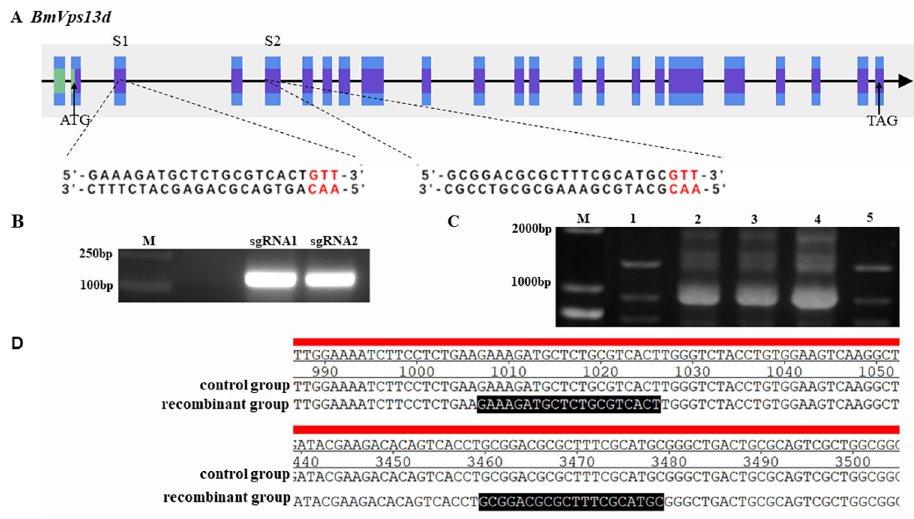
Fig 5. Cas9/sgRNA mediated gene editing of BmVps13d . (A) Schematic diagram of the sgRNA-target sites in BmVps13d . The purple boxes represent exons, and the black lines represent the gene locus. S1 and S2 are sgRNA sites shared in exon 2 and exon 4, respectively. The sgRNA target sequences are shown in black, and the protospacer adjacent motif (PAM) sequences are in red. (B) PCR amplification of sequences containing the sgRNA-target sites (137 bp). (C) Identification of the recombinant clones by PCR. Lane1, recombinant clone1 (1,337 bp) with sgRNA1 and sgRNA2; Lane5, recombinant clone2 (1,200 bp) with sgRNA1; Lane2-4, the failed recombinant clones. (D) Sequencing to verify the construction of the recombinant vector; the figure shows the partial sequence, the sgRNA target sites are highlighted in